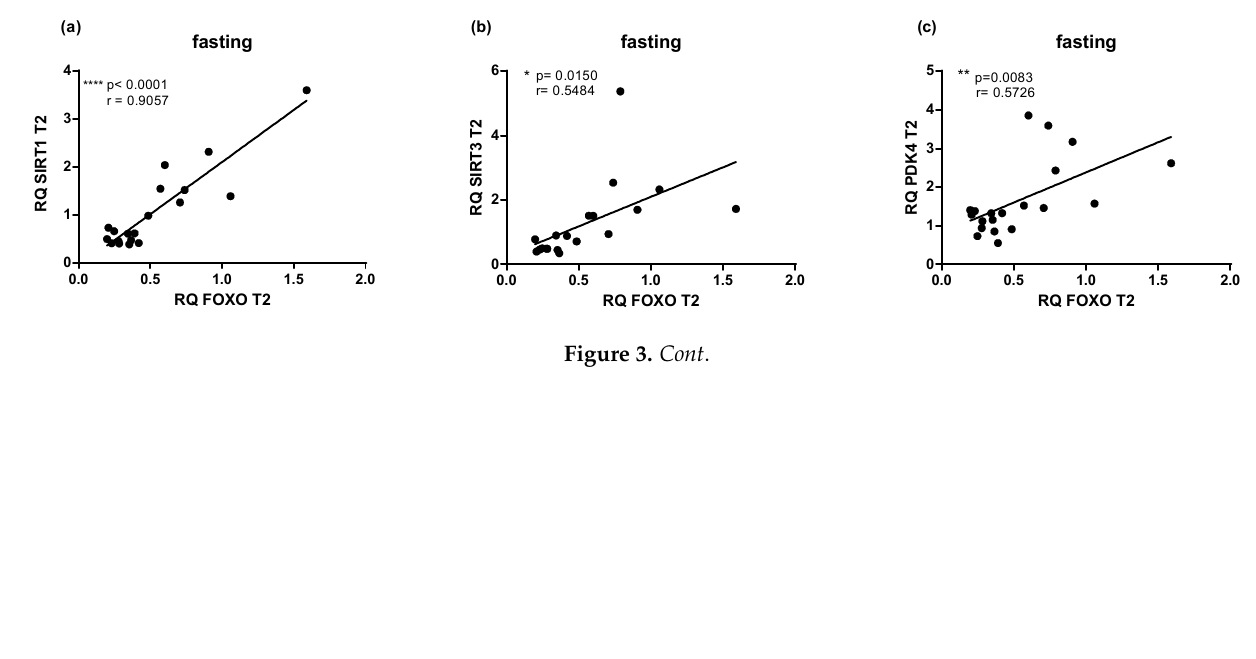
Figure 3. PF results in correlations between gene expression, age, ß-hydroxybutyrate (BHB), and mitochondrial (mt)DNA. Scatterplots illustrate Pearson correlation of different gene expressions with other markers for the fasting population and different timepoints ( a – g ). Statistical significance was defined as a p -value below 0.05. The Shannon diversity index was used to calculate α -diversity, but sequencing re- sults showed no significant differences between non-fasting and fasting groups and within the different timepoints. The dataset was further subjected to principal coordinates analysis (PCoA). Although overlapping, PCoA showed a significant grouping of band patterns according to the two groups of study participants at T2 (Figure 4c). All statistically significant changes at the species level for the fasting versus control groups are illustrated in Figure 5, which demonstrates strong differences in the microbiota composition at the species level before and after the fasting intervention. Significant de- creases were observed for: s__unspecific_02d06; s__unspecific_Dialister; s__prausnitzii; s__unspecific_Clostridiaceae; s__unspecific_Ruminococcaceae. Elevations were observed for: s__unspecific_Actinomyces; s__unspecific_Christensenella; s__unspecific_Coproba- cillus; s__lenta; s__unspecific_Granulicatella; s__mucilaginosa; s__unspecific_Staphylo- coccus;